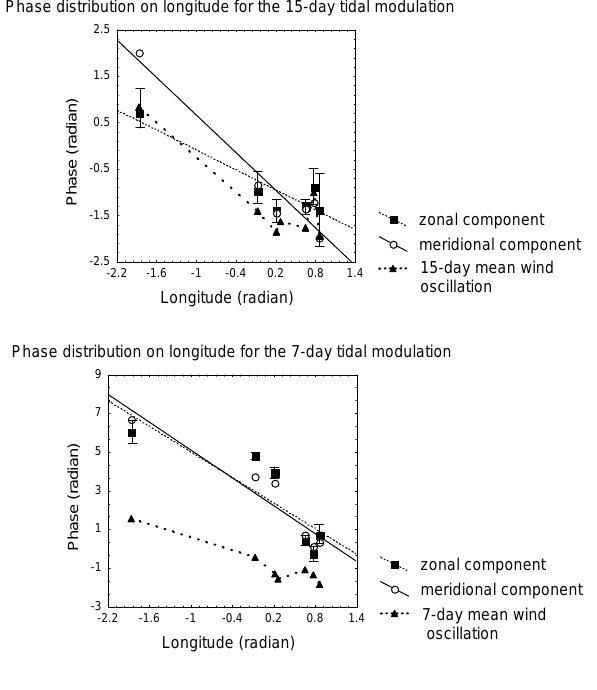
Fig. 6. Longitudinal structures of the tidal modulations and of zonal components of the mean wind